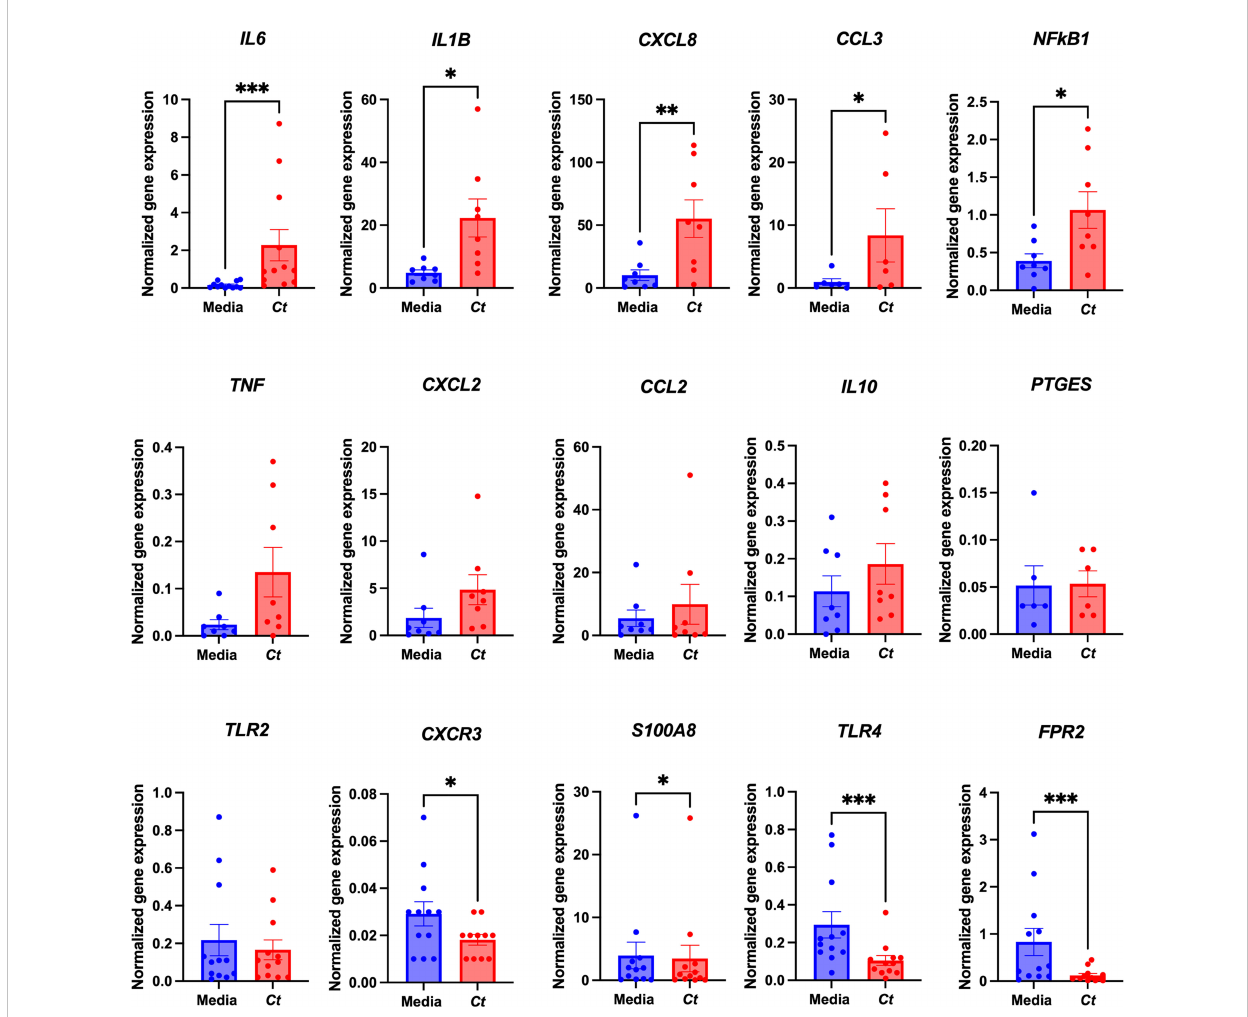
FIGURE 3 C. trachomatis -treated mast cells upregulate the expression of various effector genes. Gene expression analysis of 89 acute in fl ammatory genes of CBMCs treated with C. trachomatis MOI = 1 and paired medium controls was carried out using a PCR array. qPCRs for selected genes from the array were carried out on C. trachomatis -treated CBMCs from multiple donors and paired medium controls. Gene expression was normalized to two reference genes, GUSB and HPRT , and data are presented as 2 − △ Cq . The data are graphed as mean ± SEM. Graphs represent three individual experiments, and each point represents an individual donor. * p < 0.05, ** p < 0.01, and *** p < 0.001, as determined by a nonparametric Wilcoxon signed-rank